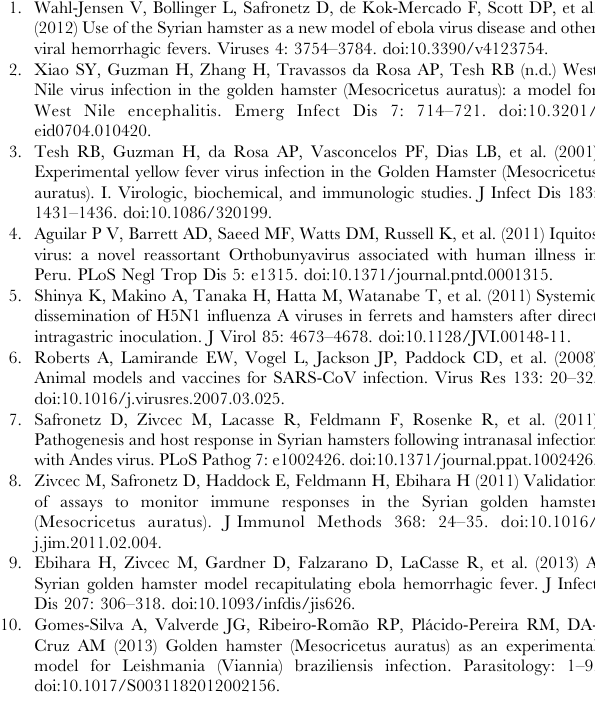
Table S2 Alignment positions of the Syrian hamster transcriptome over the Chinese Hamster Ovary cell genome. Table showing the alignment positions of the Syrian hamster transcriptome sequences to the draft of the Chinese hamster genome. We found that 85,652 contigs and singletons of our library have been aligned on the Chinese Hamster Ovary cell genome draft. For each aligned Syrian hamster transcriptome sequence, the CHO genome segment, the start alignment position, the end alignment position, and the strand are indicated. Table S3 List of sequences used to infer the phylogenic tree. Table providing the list of contigs and singletons used to construct the phylogenic tree shown in figure 4. All the 611 contigs and singletons in this table have been significantly aligned on the transcriptomes of species having the highest number of commonly aligned